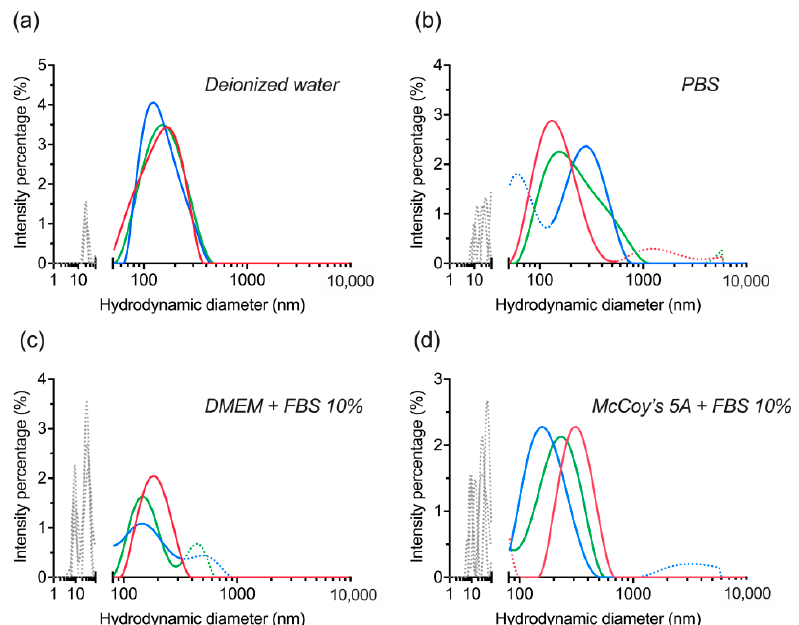
Figure 6. Evaluation of colloidal stability of lyophilized dBSA-UCNP-NOBF 4 in different buffers after one week of lyophilization and mixed by vortexing and ultrasonication, based on the results of three repeated size measurements (shown in blue, red, and green) by DLS: ( a ) in deionized wa- ter; ( b ) in PBS; ( c ) in DMEM cell culture medium supplemented with 10% FBS; ( d ) in McCoy’s 5A cell culture medium supplemented with 10% FBS. Gray and/or dotted lines below 100 nm corre- spond to the presence of proteins and protein aggregates; dotted lines over 300 nm are aggregates.